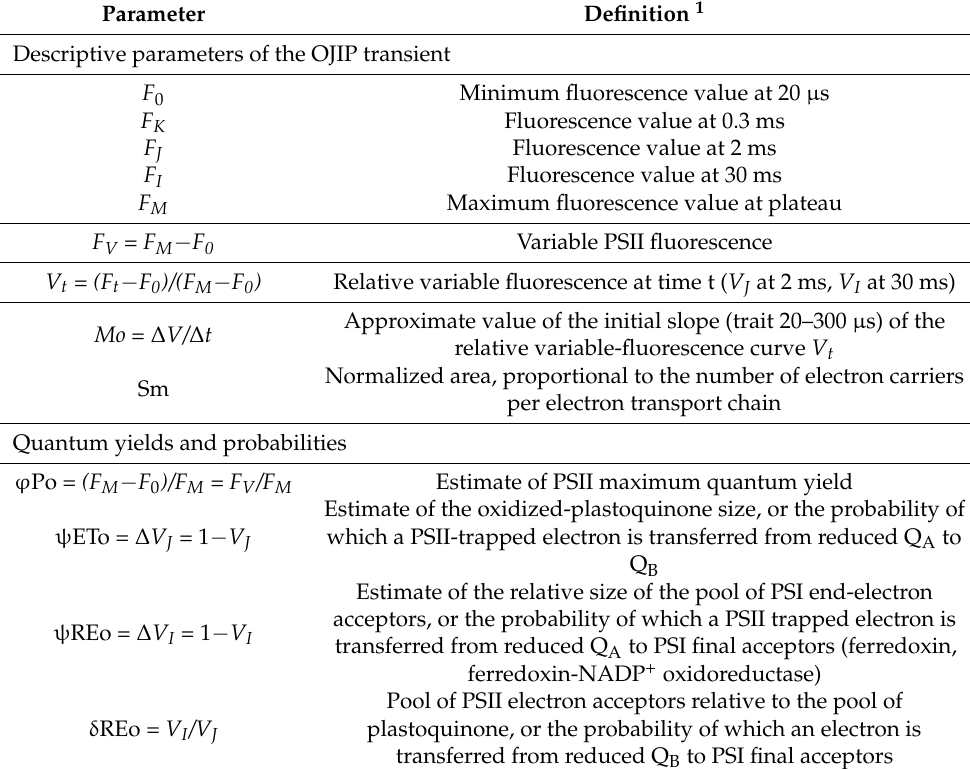
Table A2. Measured and calculated parameters from the fast-chlorophyll- a -fluorescence